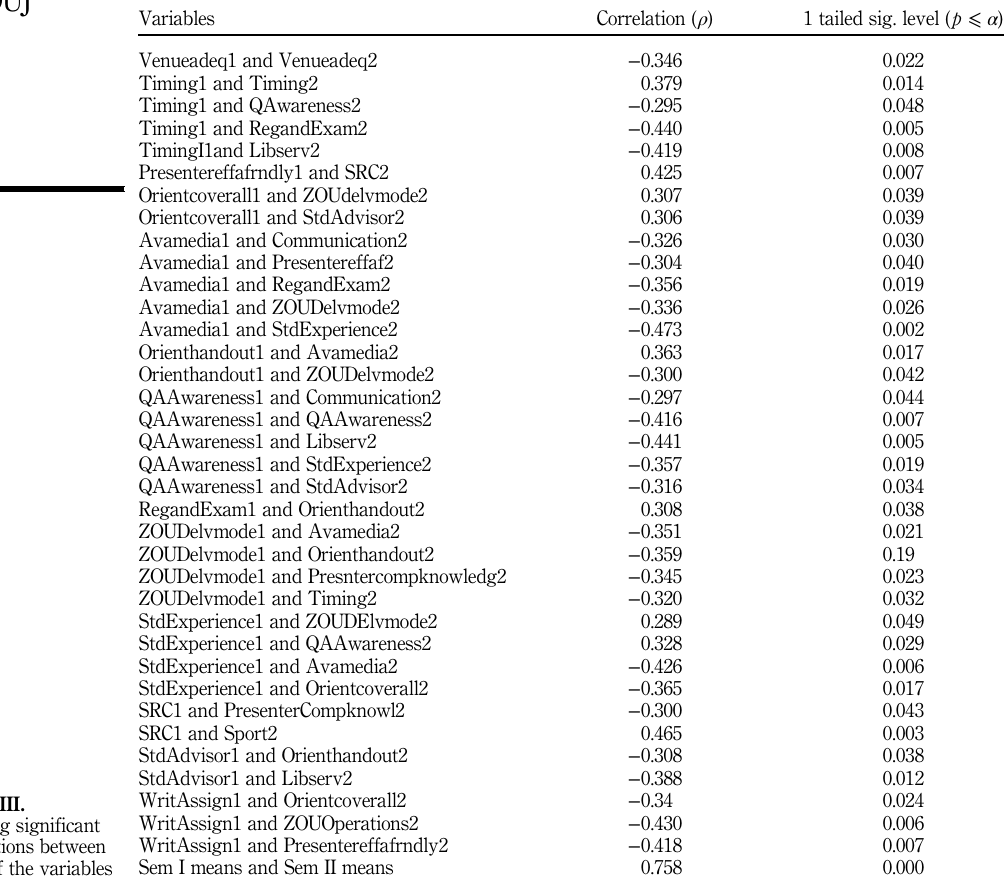
Table III. Showing significant correlations between some of the